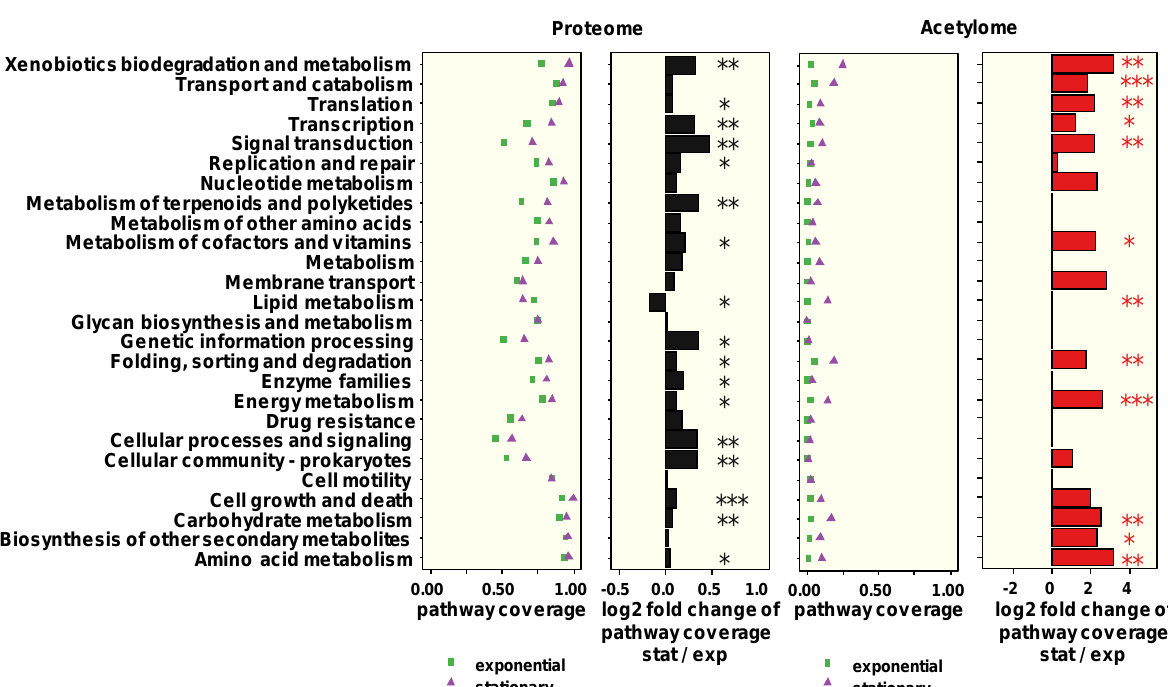
Figure 1. Global functional analysis of quantified proteins (left two columns) and acetylated proteins (right two columns). The displayed pathway coverage corresponds to the ratio of the number of quantifiable proteins or identified acetylated proteins, and the number of proteins encoded in the genome assigned to each pathway. The log2 fold changes were calculated from the pathway coverages of the two growth phases. Please note that the log2 fold changes of pathway coverages of the acetylome are zero if no acetylated proteins were detected in the exponential phase. Significance of differences between exponential and stationary phase is displayed as asterisks (* p < 0.05, ** p < 0.01, *** p < 0.001).